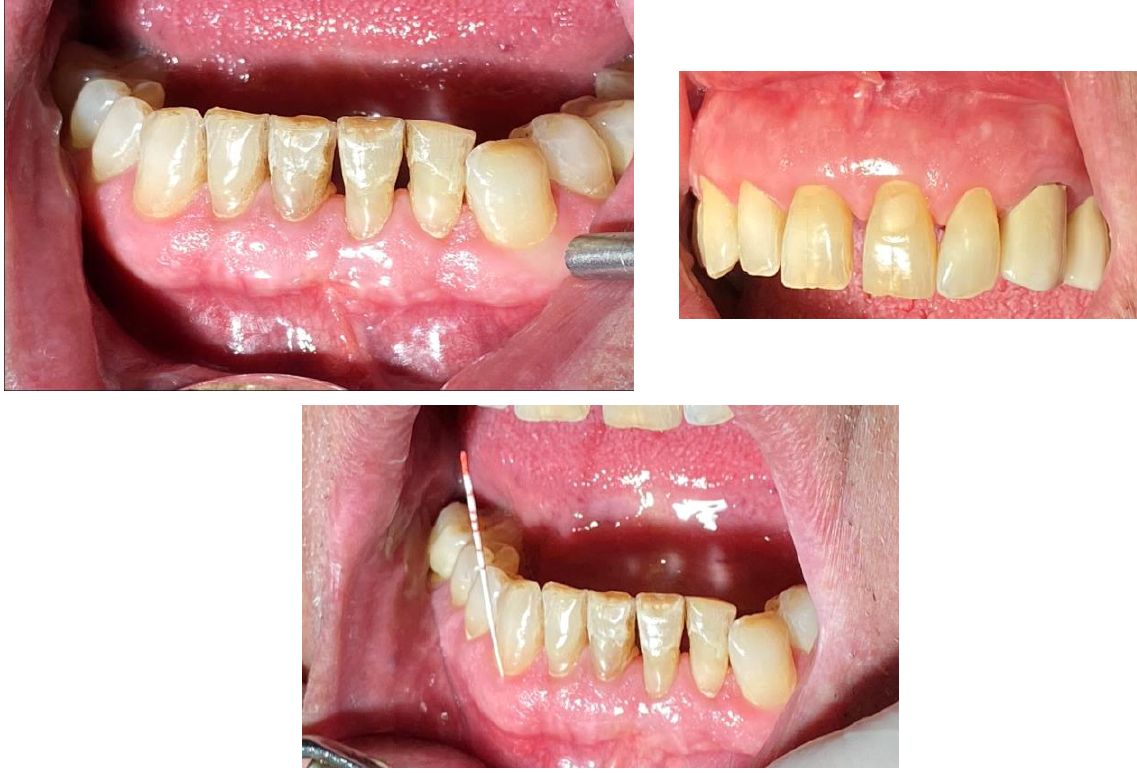
Figure 6. Patient age 53 years, with chronic periodontitis where can are distinguished the pink gingiva, gingival recession and the way of recording the amount of gingival